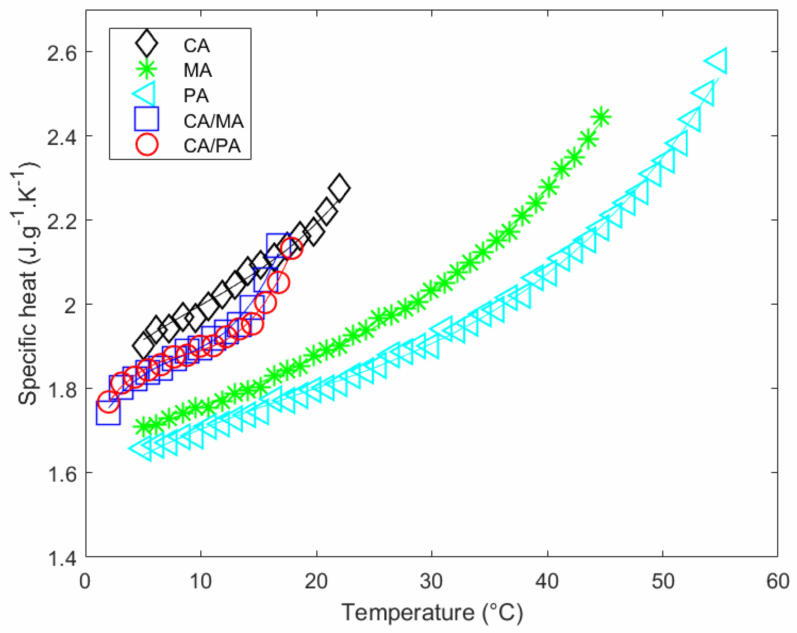
Figure 3. Specific heat measurements versus temperature of pure fatty acids and eutectic mixtures in the solid state.